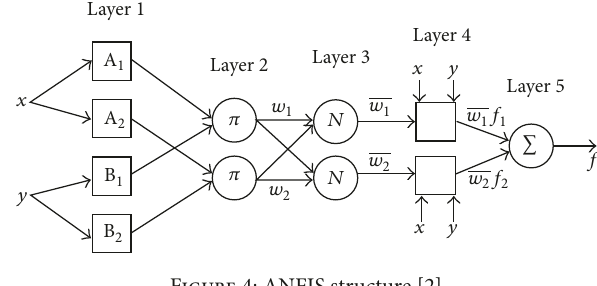
Figure 4: ANFIS structure [2].